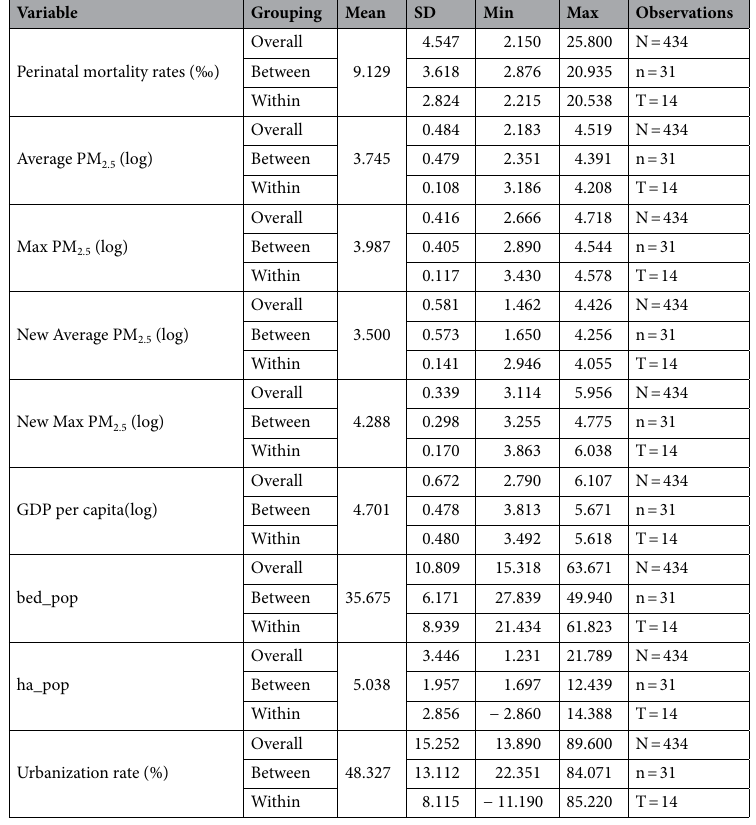
Table 1. Descriptive statistics for the